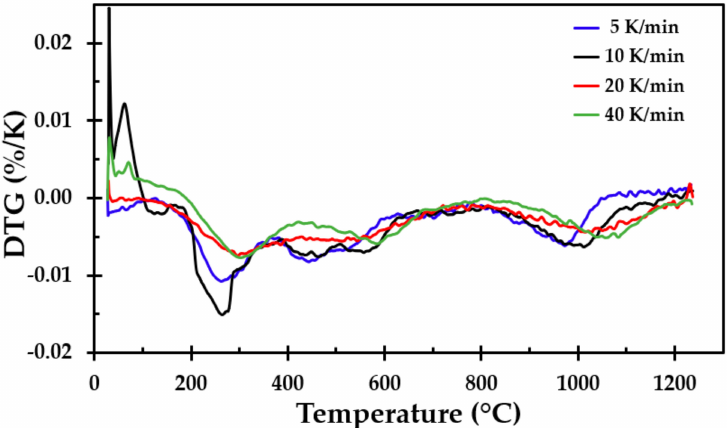
Figure 11. Di ff erential thermogravimetric (DTG) analysis of the results presented in Figure